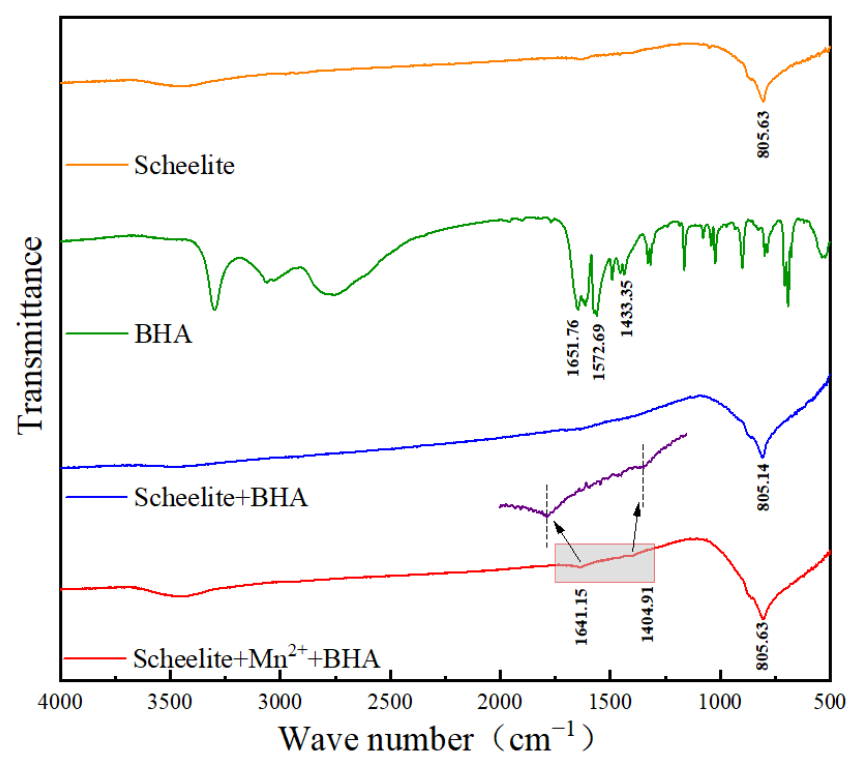
Figure 6. Infrared spectra of pure scheelite; pure BHA; scheelite with added BHA; and scheelite with added BHA and Mn 2+ .